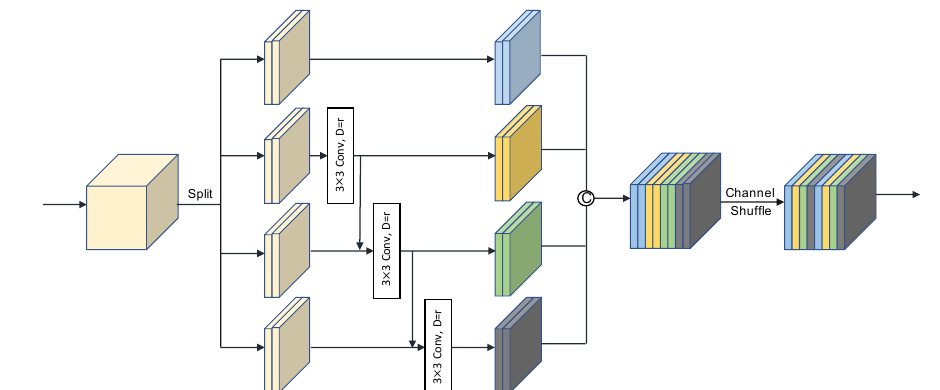
Figure 5. Illustration of the hierarchical-atrous convolution block (HACB). It adopts the group convolution and the hierarchical connection style to generate information, and the “channel shuffle” operator is used for information communication between different splits.